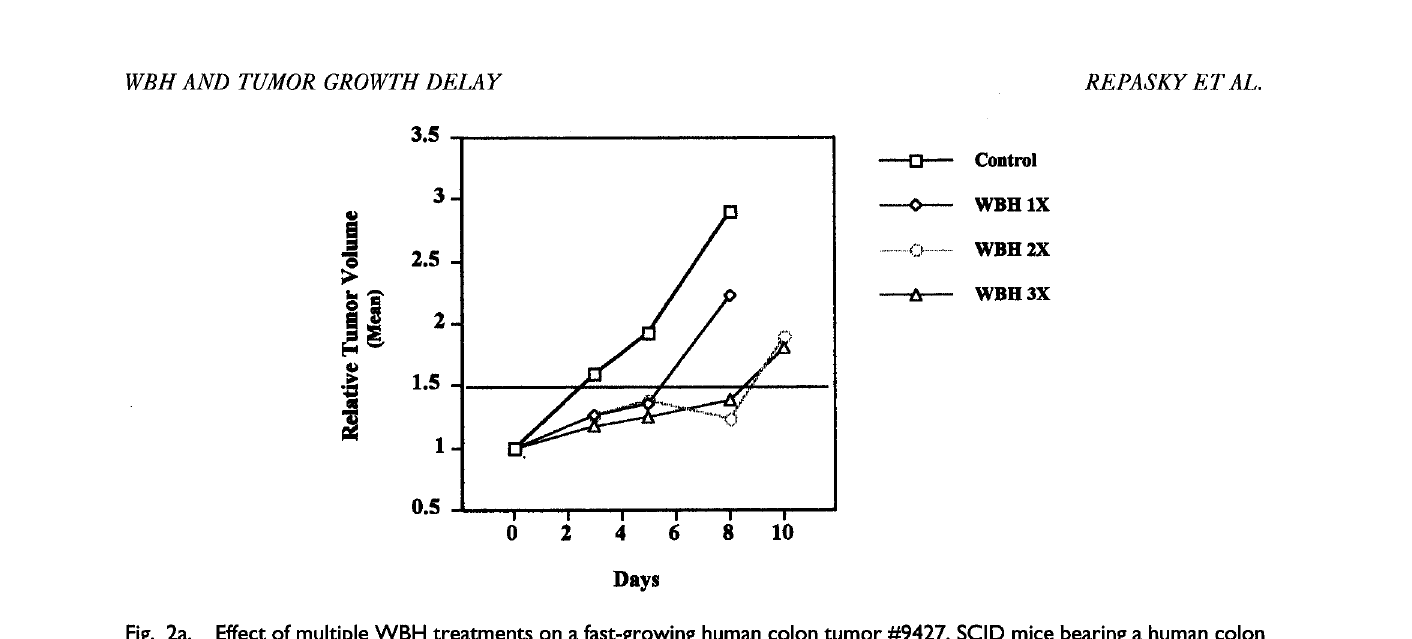
Fig. 2a. Effect of multiple WBH treatments on a fast-growing human colon tumor #9427. SCID mice bearing a human colon tumor were treated with WBH for 6 hours on days 0, 5, and II. Tumors were measured with calipers regularly for the duration of the experiment. Relative tumor volume was calculated and graphed vs. days. Control, n 4; WBH Ix, n 4; WBH 2x, n=4;WBH 3x, n=4.